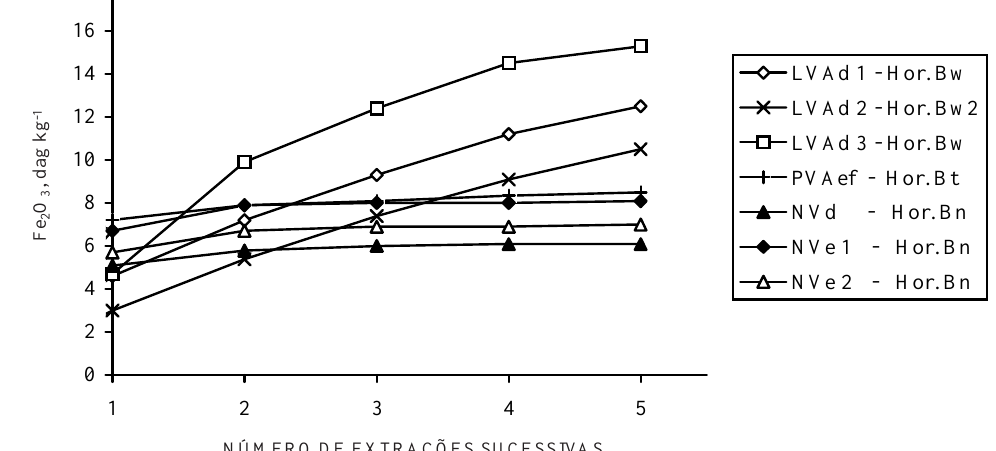
Figura 3. Teores cumulativos de Fe solos